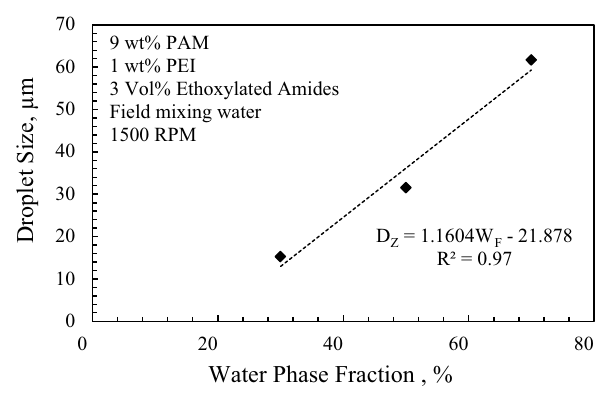
Fig. 8 Droplet size of the emulsified gels at different water-phase fractions at 25 °C